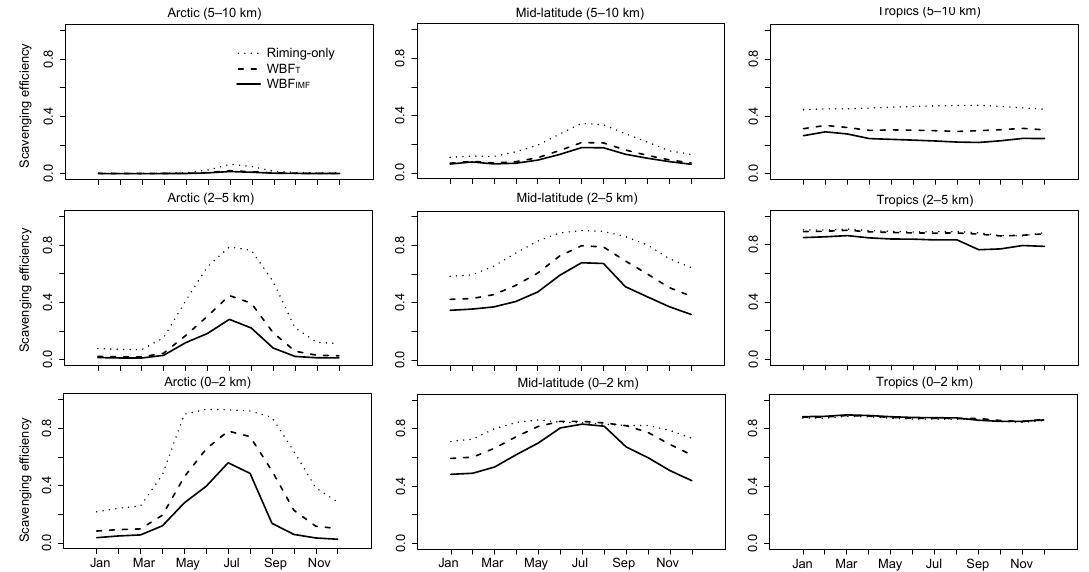
Figure 2. GEOS-Chem-simulated monthly mean BC scavenging efficiency in the Arctic (60–90 ◦ N), mid-latitudes (20–60 ◦ N) and the tropics (0–20 ◦ N) in the boundary layer (0–2km), the lower troposphere (2–5km) and the middle to upper troposphere (5–10km). Results are averages for